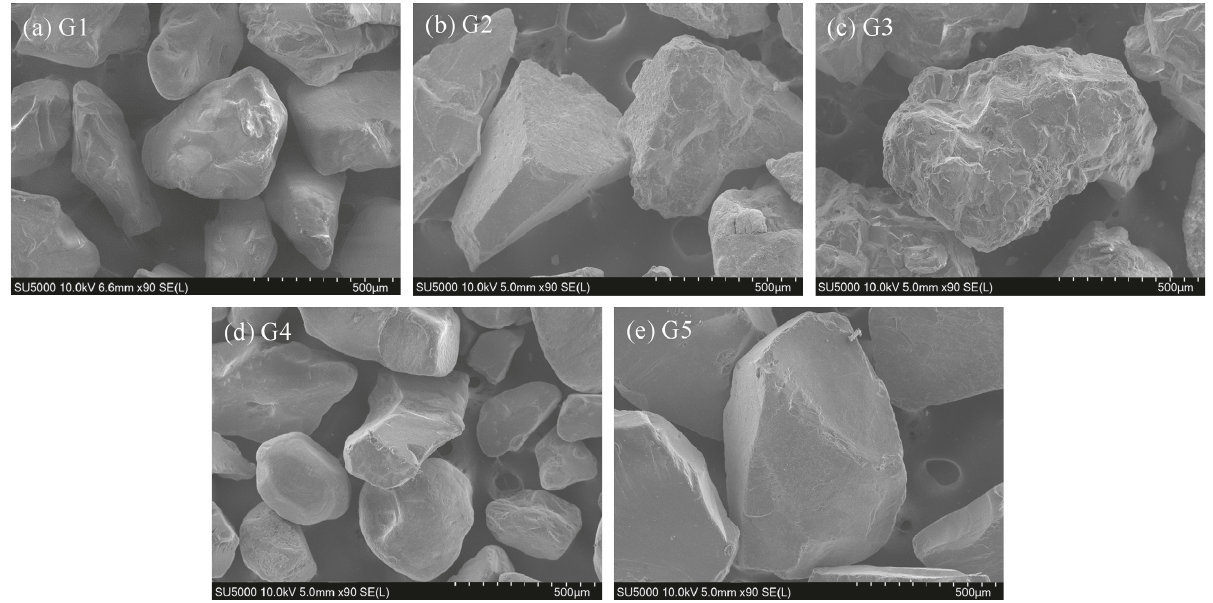
Figure 3: SEM images of garnet particles: (a) G1, (b) G2, (c) G3, (d) G4, and (e) G5. Table 2: Characteristics of